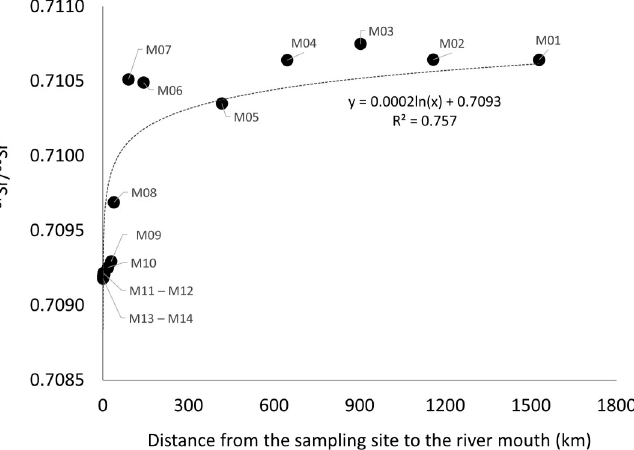
Fig 4. Water 87 Sr/ 86 Sr ratio versus distance from the sea along the Mekong River. Water 87 Sr/ 86 Sr versus distance from the sea along the Mekong mainstream. Distances were estimated using Google Earth Pro. Labels at each point refer to the sampling sites in Fig 1 and Table 1.